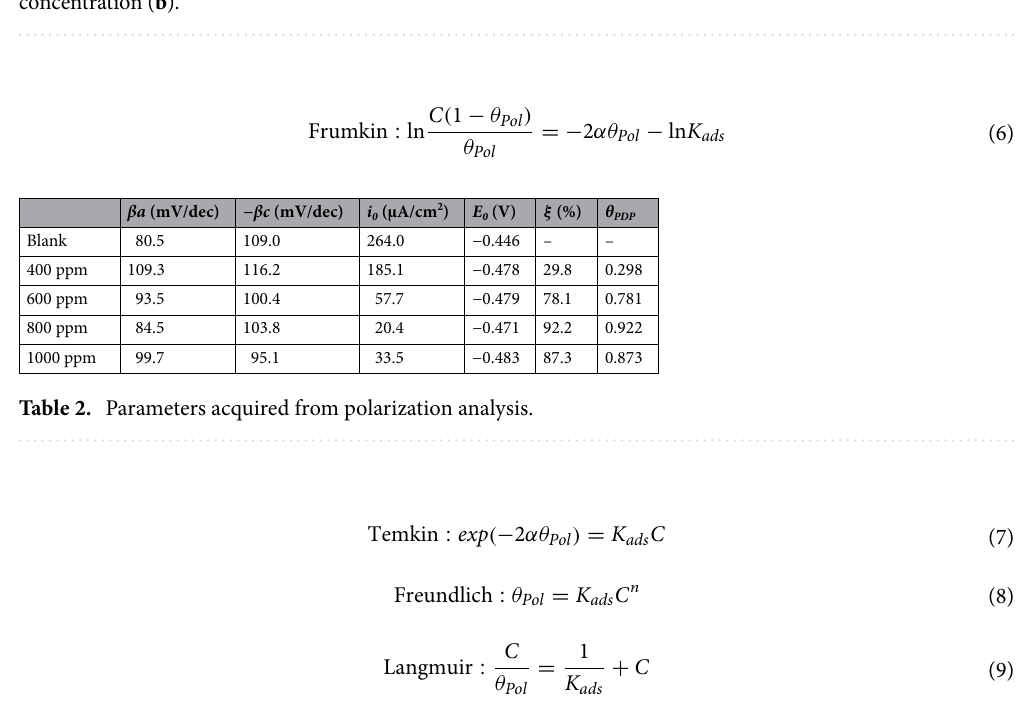
Figure 4. The corrosion inhibitor adsorption process: at optimum concentration ( a ) and above optimum concentration ( b ).